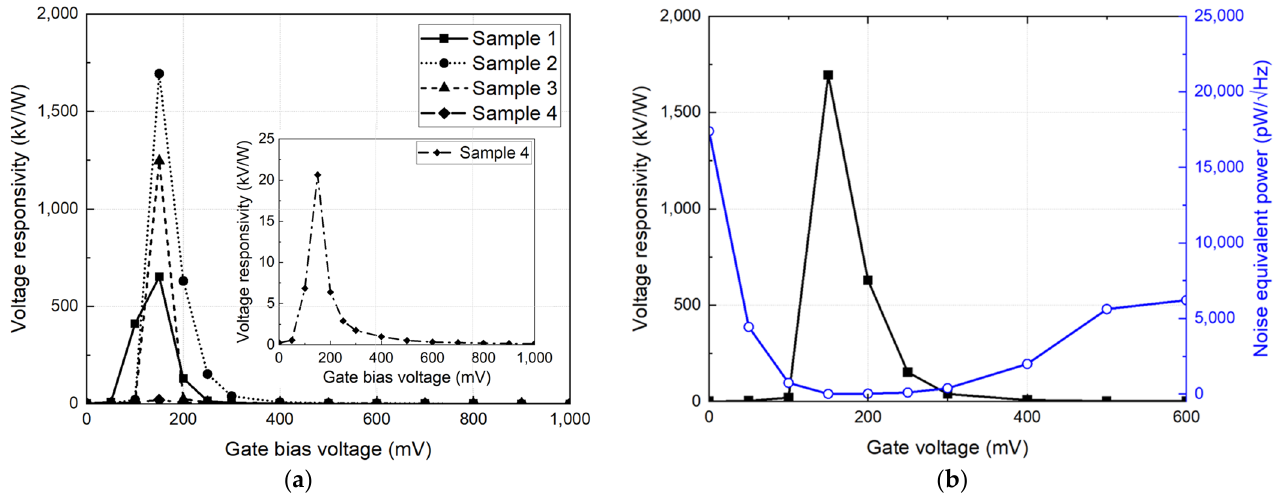
Figure 13. Detection performances of the CMOS detector unit module: ( a ) Voltage responsivities of four detector unit modules randomly selected in the array. ( b ) Voltage responsivity and noise- equivalent power of sample 2 among the modules. Table 1. Performance comparison of the 200 GHz CMOS detector-integrated circuits. Ref.